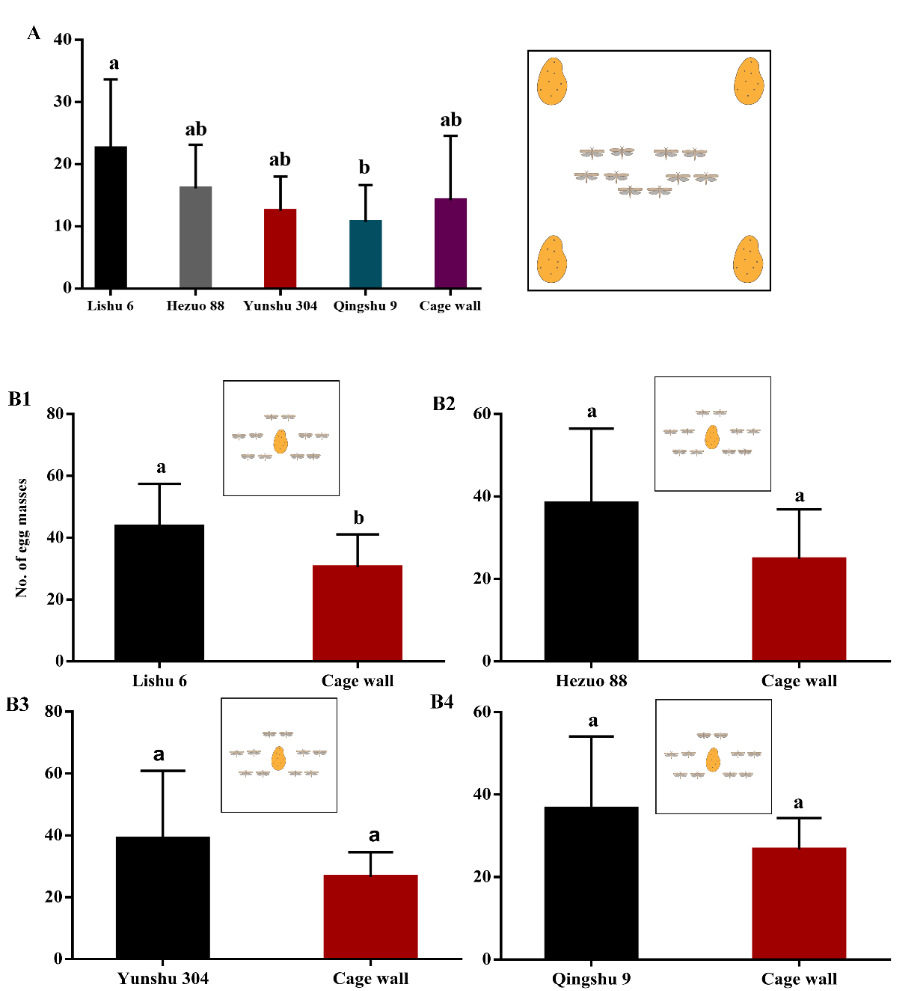
Figure 4. Number of egg masses laid by P. operculella on four different potato tuber varieties and the cage wall. Different lowercase letters indicate means are significantly different at p < 0.05. ( A ): choice test; ( B1 – B4 ): non-choice test.